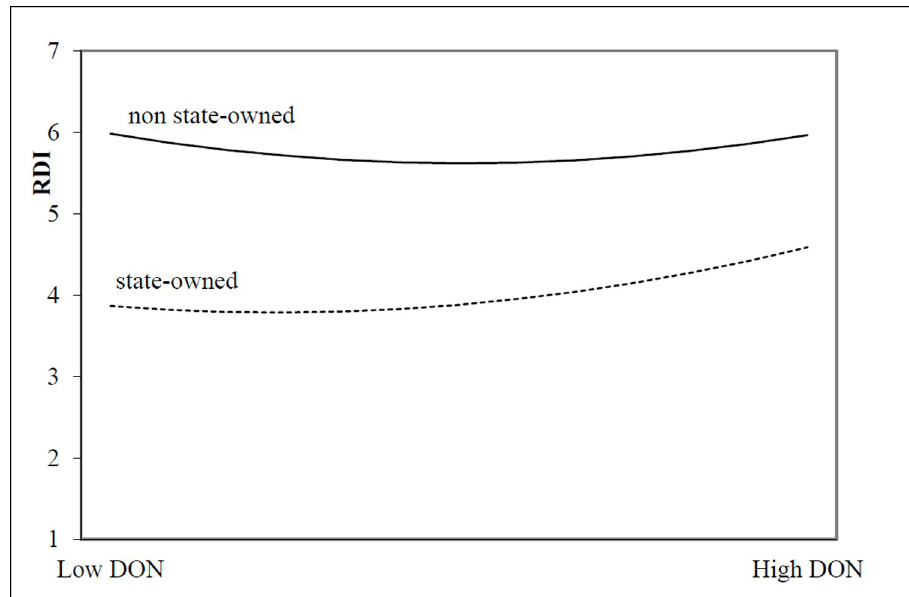
Fig 6. The moderating effect of state-ownership on the relationship between tool motivation-oriented charitable donation and innovation investment.